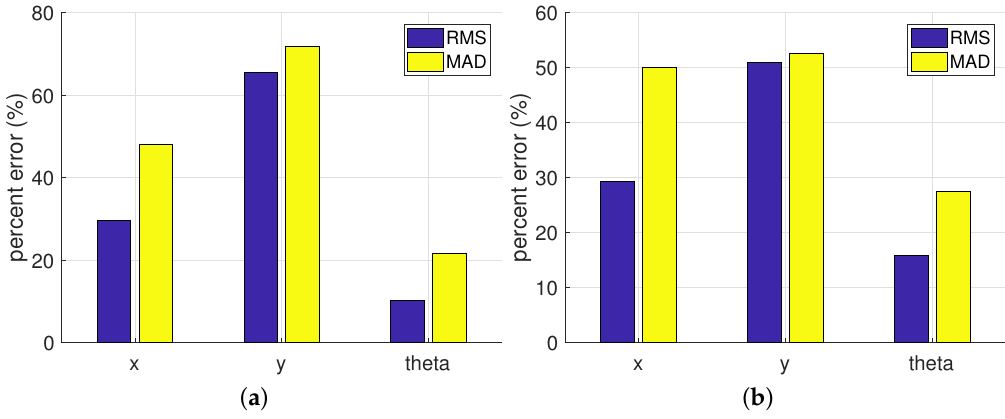
Figure 23. RMS and MAD percent errors results for EKF-SNPID vs PID with anti-windup. The percent errors x, y and theta were computed based on the RMS and MAD results of the errors x e , y e and θ e from Table 4, respectively. ( a ) Percent error results for sinusoidal trajectory. ( b ) Percent error results for rose curve